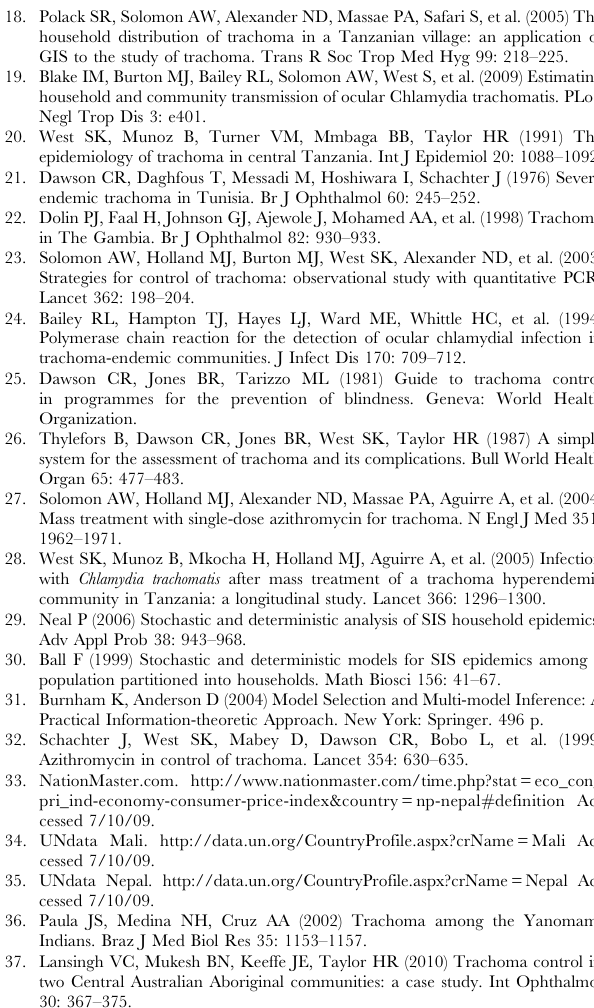
Table S4 Sensitivity (a) and specificity (b) of active disease as a marker of infection in the household (both limiting clinical diagnosis to children under 10 years old and assessing clinical disease in all ages) for four trachoma endemic communities. Numbers in square brackets indicate 95% binomial confidence intervals. There is no statistical significant difference between assessing active disease in children under ten years old and assessing disease in all ages (Fisher’s exact test p . 0.05).